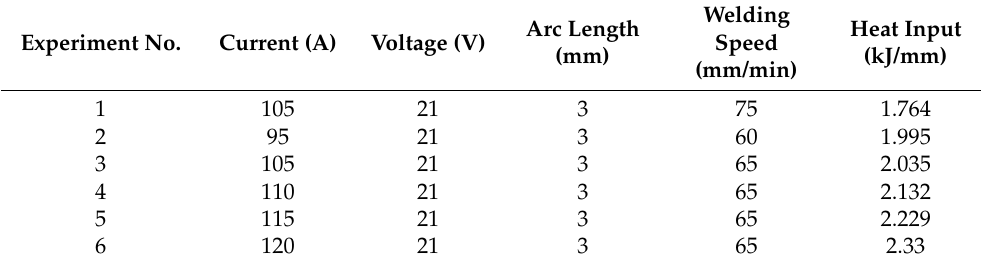
Table 3. Welding parameters used in